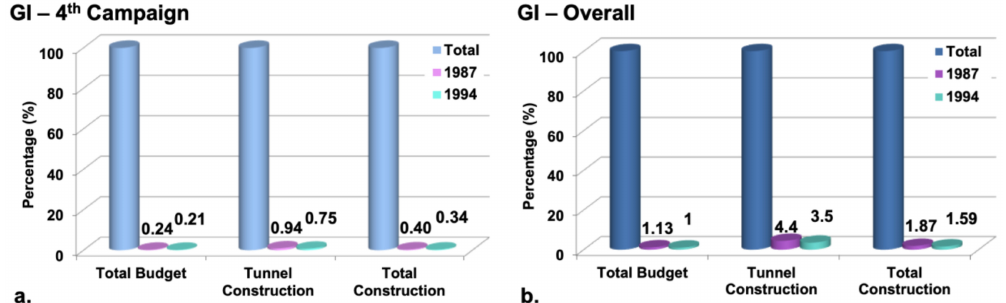
Figure 10. Expenditure as percentage of the cost for 1987 and 1994 of ( a ) the fourth Ground Investigation (GI) campaign and ( b ) the overall GI.